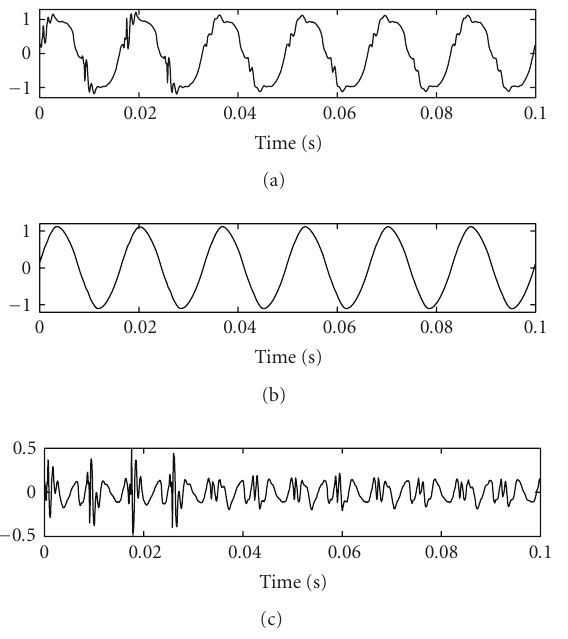
Figure 2: (a) Monitored voltage signal, { x ( n ) } , (b) fundamen- tal component, { f ( n ) } , (c) harmonic and transient components, { h ( n ) } + { u ( n ) } .